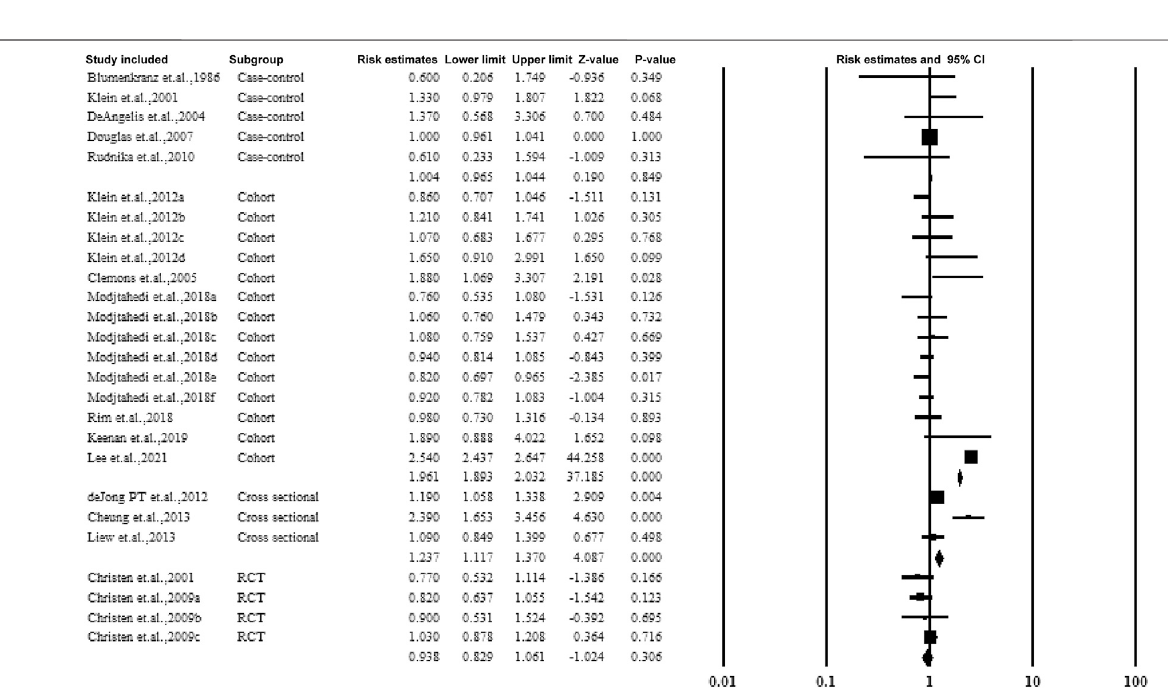
Frontiers in Pharmacology |